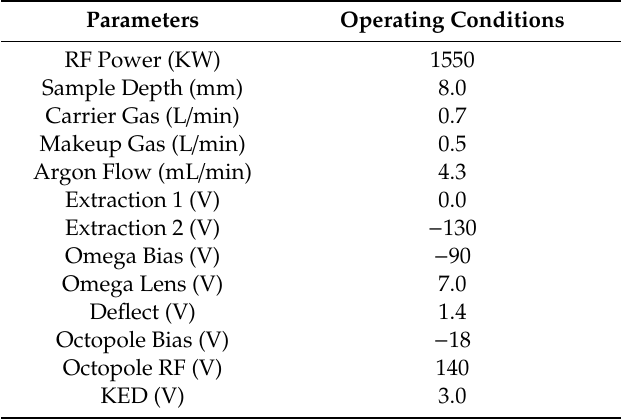
Table 1. Summary of inductively coupled plasma-mass spectrometry (ICP-MS) operating